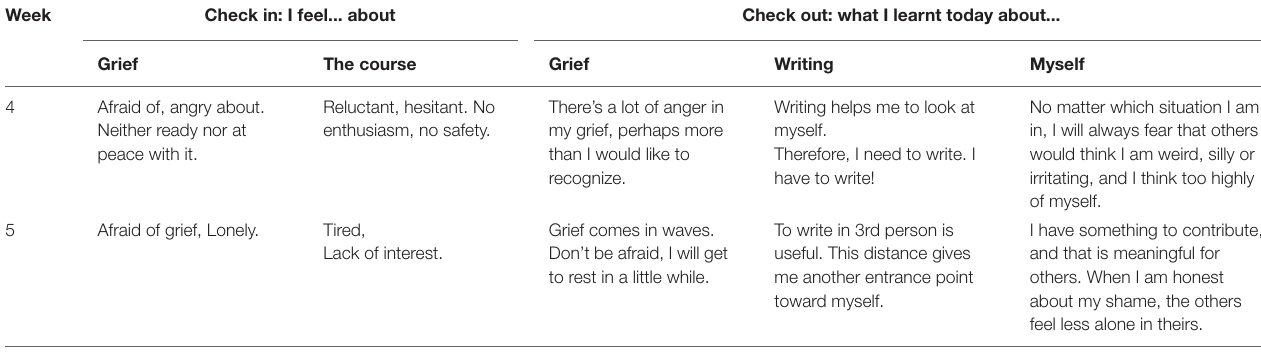
TABLE 3 | Journaling summary from the check-in and check-out prompts. Week Check in: I feel...